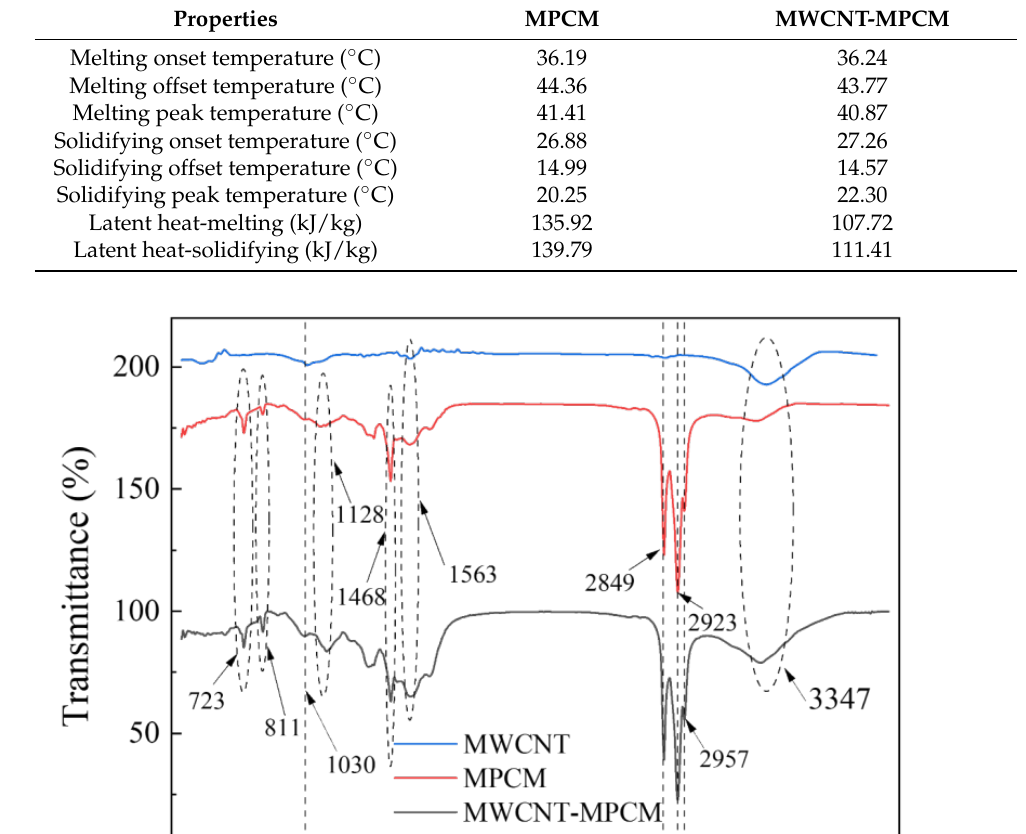
The MWCNTs and MPCM were mixed in a specific ratio with deionized water to